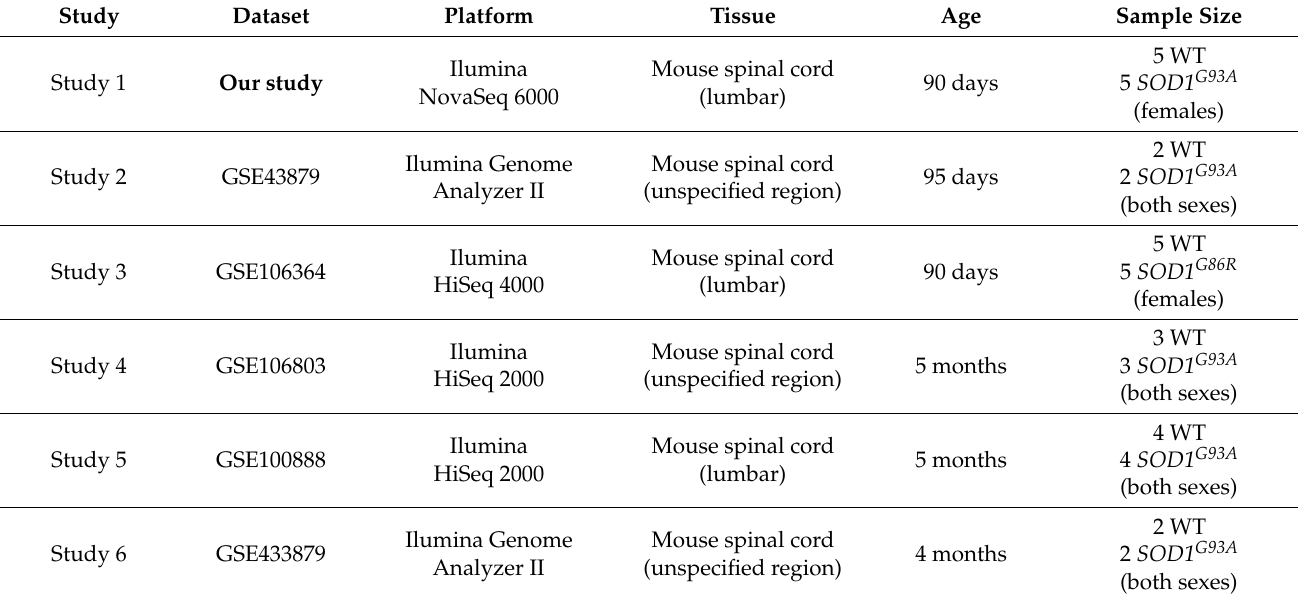
Table 3. Summary of GEO datasets used for the